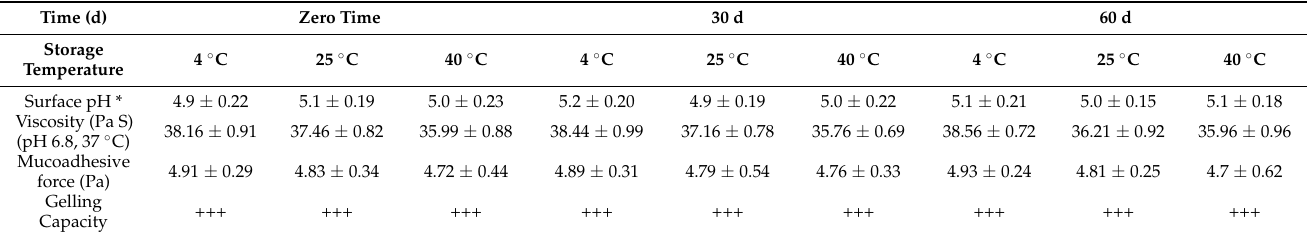
Table 3. Physicochemical evaluation of the most satisfactory in situ gel formulation, F3 during stability study (means ±